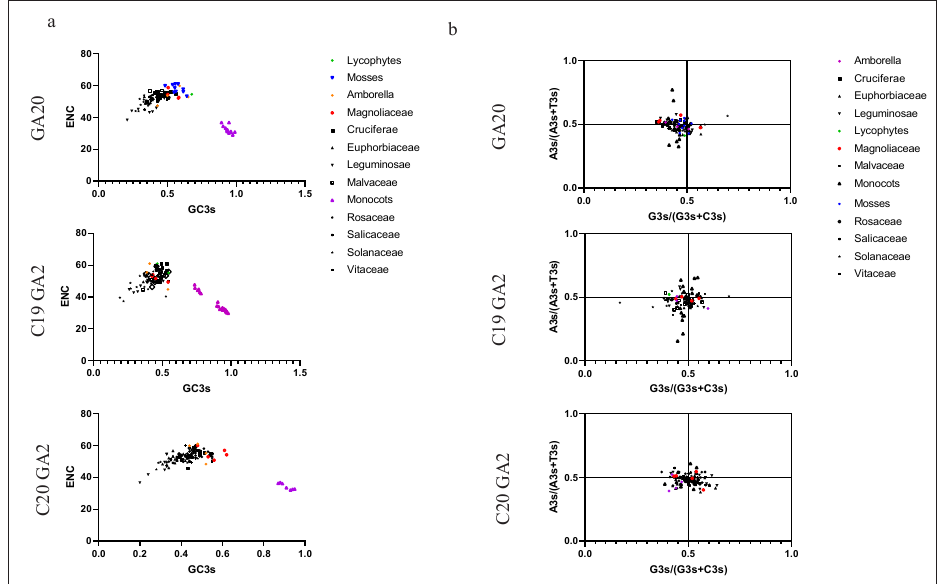
Figure 6. ENC-plot analysis and PR2-plot analysis in GA20ox , C19GA2ox , and C20GA2ox . ( a ): The points represent a single gene, ENC value of each gene as the ordinate and the GC3s value as the abscissa. Different shapes represent different families, and blue inverted triangle represents mosses, the green diamond represents lycophytes, the organ filled circle represents Amborella, the purple triangles represent monocots and the hollow red circle represents L. chinense . ( b ): This plot is tested with AT bias (3s/A3s + T3s) in the y-axis and GC bias (G3s/(G3s + C3s) in the x-axis in a graphical presentation. Different color and shapes represent different